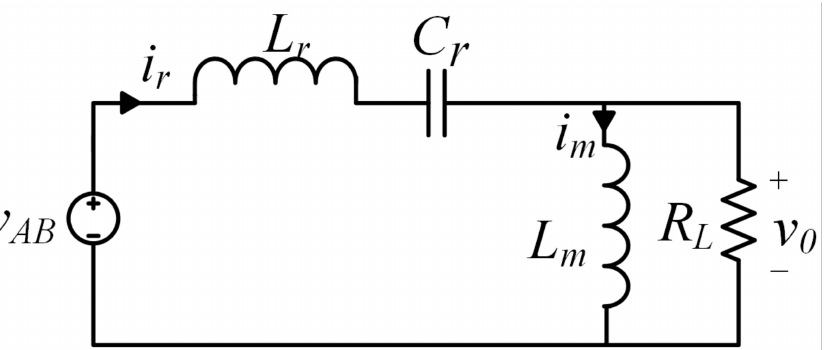
Figure 3. Equivalent circuit of the full-bridge LLC resonant converter.